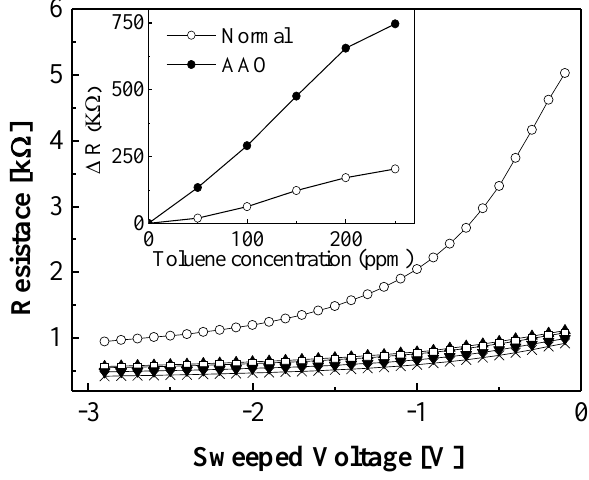
Figure 6. Comparison of the imprinted and non-imprinted device operating characteristic.